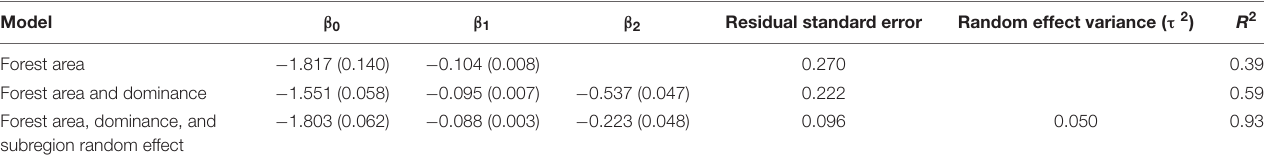
TABLE 3 | Fixed effect and mixed effect linear regression results for predicting the log coefficient of variation in tree aboveground live carbon as a function of area, dominance, and subregion.